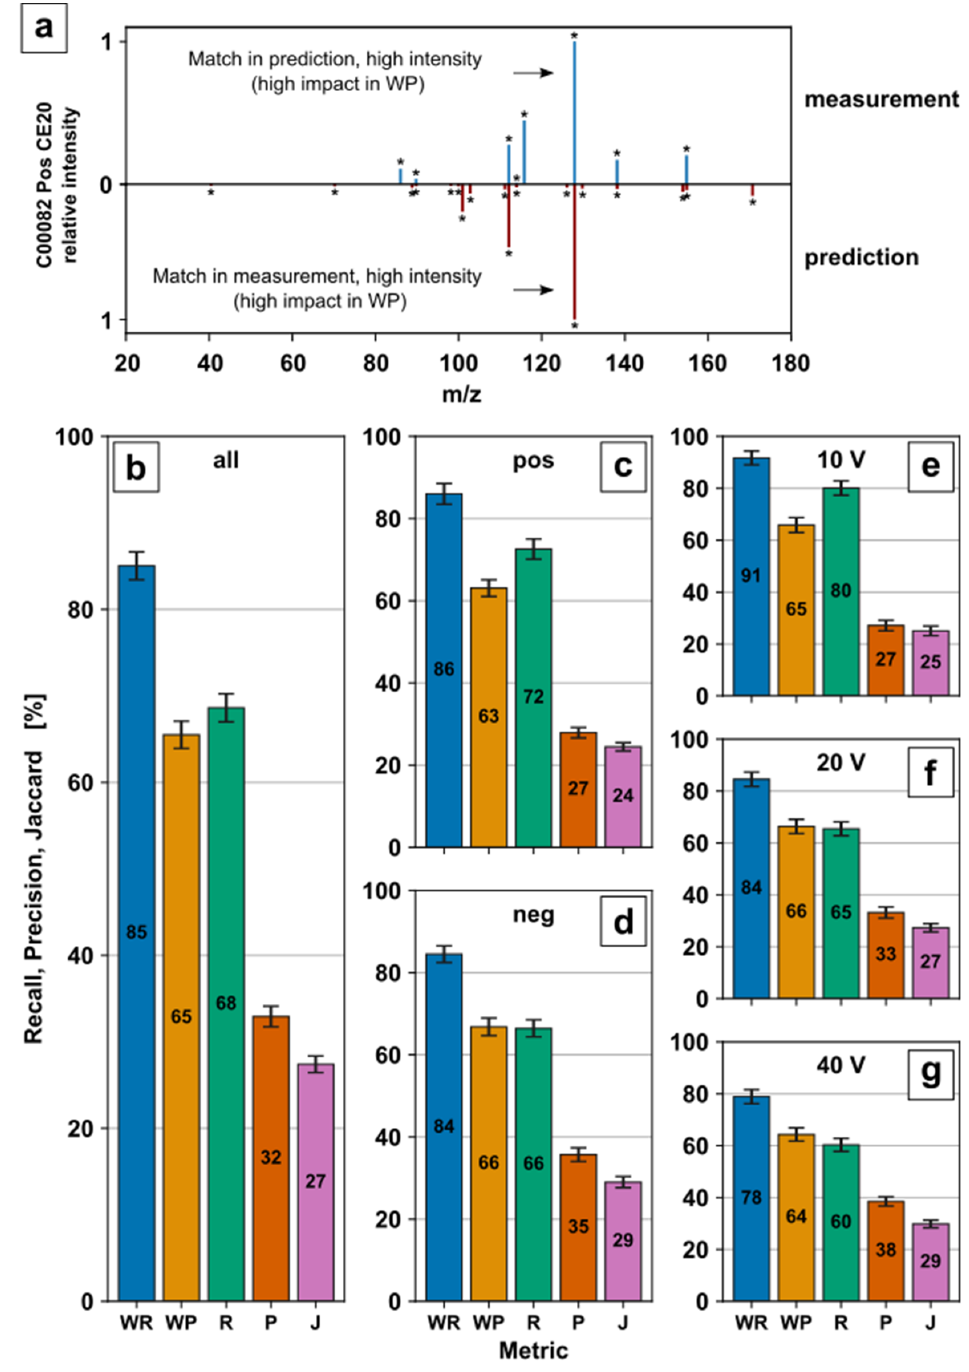
Figure 3. Evaluation of fragment prediction: Experimental product ion spectra of 61 metabolites were acquired by manual optimization procedure with high-resolution MS for collision energies at ±10 V, ±20 V, and ±40 V for positive and negative ionization mode (if applicable); ( a ) Measured and predicted mass spectra for tyrosine (C00082) in positive ionization mode and +20 V collision energy. An asterisk (*) highlights a fragment ion. Recall (R), Precision (P), Weighted Recall (WR), Weighted Precision (WP) and Jaccard score (J) for all predictions ( b ), predictions by ionization mode ( c , d ) and predictions by collision energy ( e – g ). Bars represent mean values with standard error. The percentage of peaks in the measured spectrum that have a matching peak in the predicted spectrum (R) is 80% for 10 V (Figure 3e) and 60% for 40 V (Figure 3g), showing